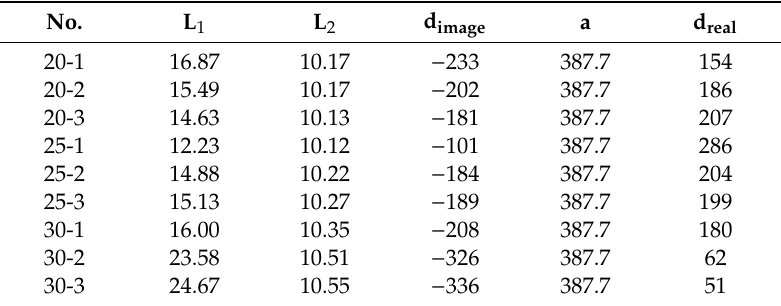
Table 7. Relative distance using a monocular camera (CPNC), [cm].